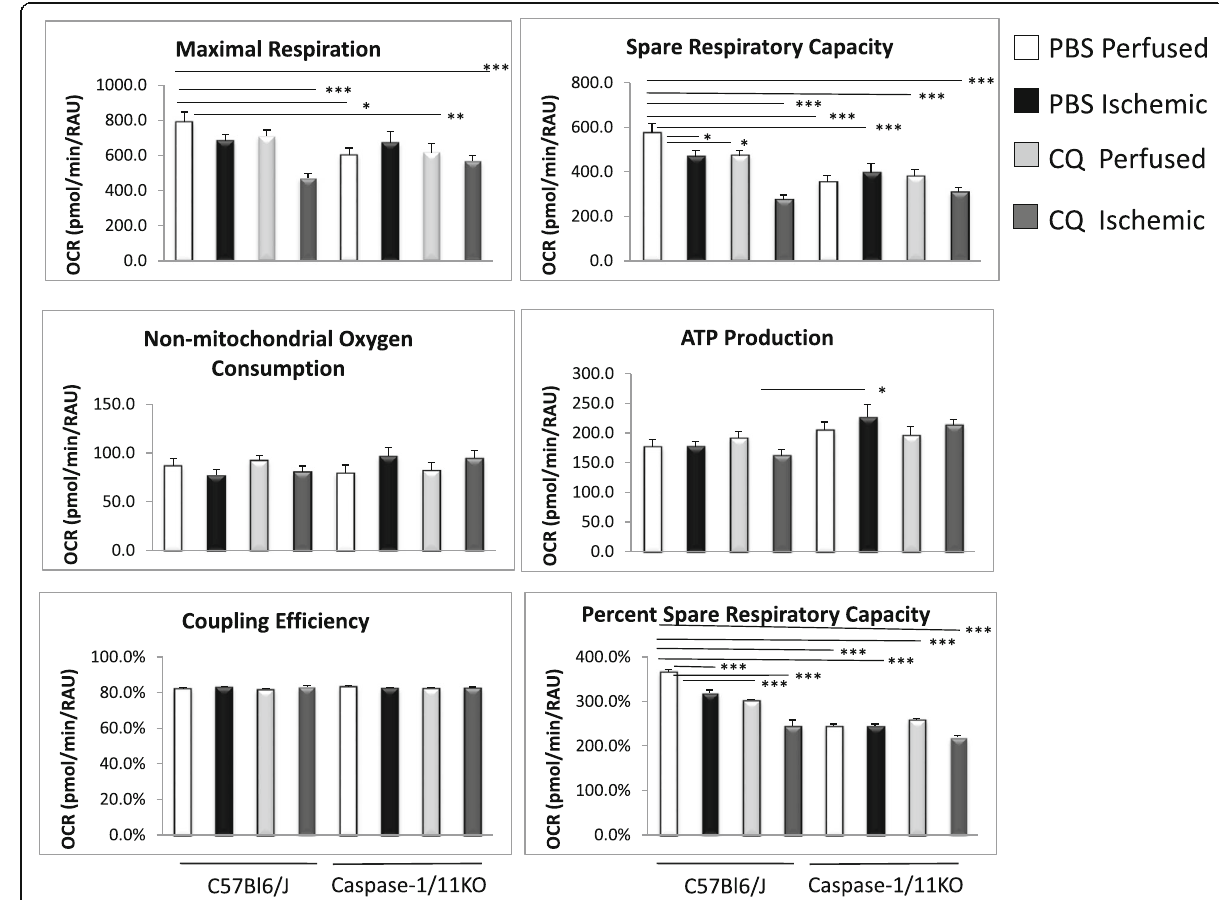
Fig. 9 Ischemia, CQ absence of caspase-1/11signaling alter oxidative metabolism in muscle stellate cells (MuSC). Seahorse ™ analysis of maximal respiration, spare respiratory capacity (including %), non-mitochondrial oxygen consumption, ATP production, and coupling efficiency in MuSC harvested from tibialis anterior (TA) of nonischemic and ischemic limbs of C57Bl6/J (WT) and caspase1/11KO mice at 21 days after femoral artery ligation (FAL) treated with either PBS or CQ (50 mg/kg); * p < 0.05, ** p < 0.01, *** p <